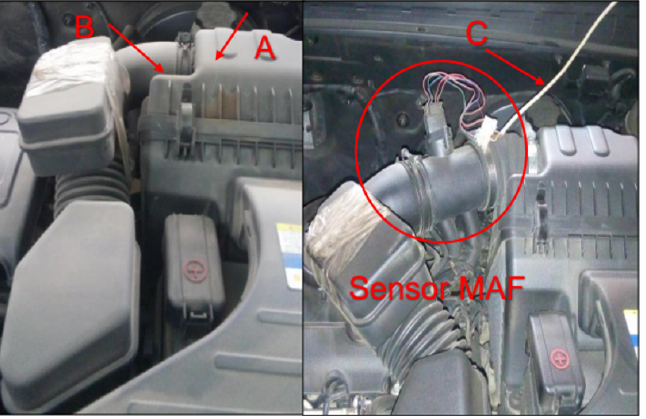
Figure 6. MAF sensor